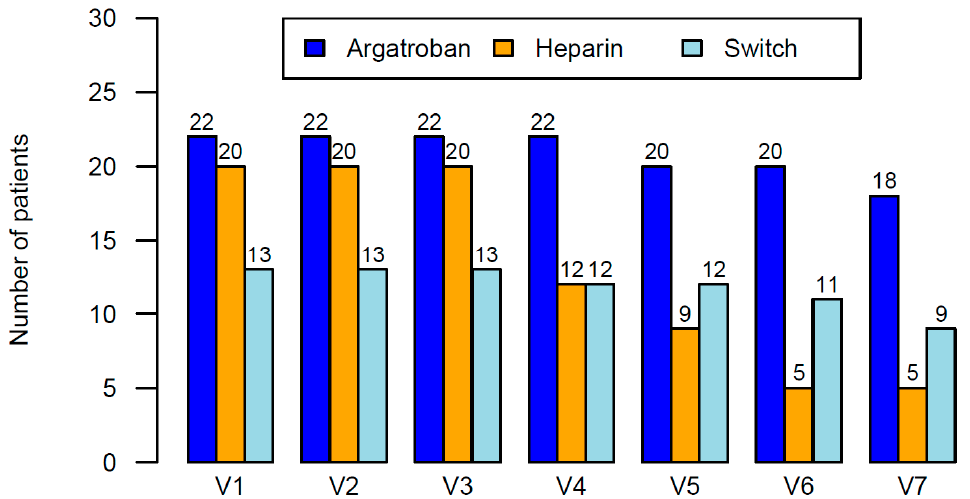
Figure 4. Number of patients per visit in the heparin, argatroban, and switch group. V indicates the study visits at pre-defined time points.